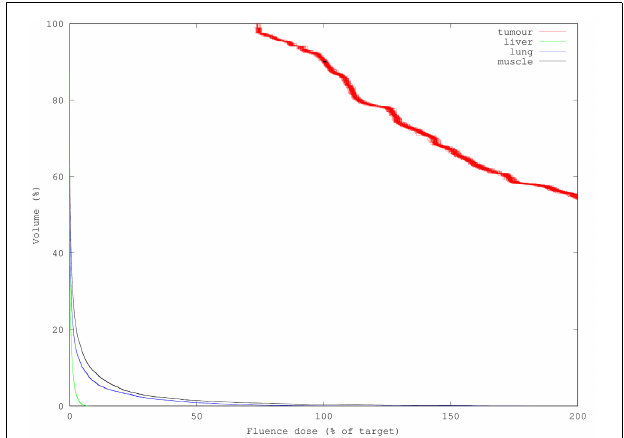
D 90 standard deviation was reduced to 0.6%.